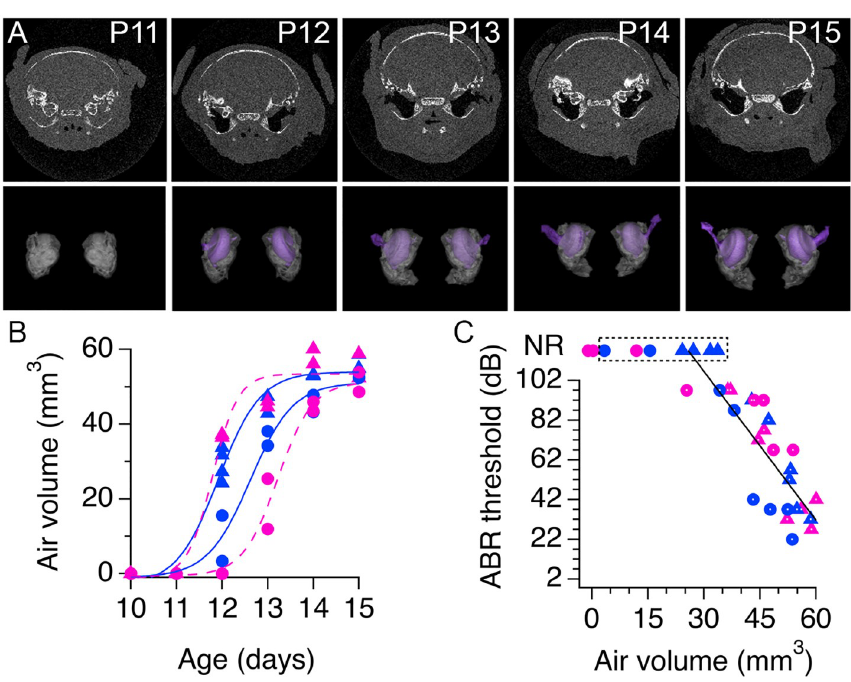
Fig 5. Relationship between development of the middle ear cavity and auditory brainstem response (ABR) wave 1 thresholds. A , Top, developmental series of micro-CT X-ray scans of pups from a low licking and grooming (low-LG) litter. White indicates bone, grey is soft tissue and black is air. Bottom, 3D rendering of segmented bone (gray) and air (purple) contrast obtained from tomographic data. B , Air volume measured at different ages in pups from two low-LG (magenta) and two high licking and grooming (high-LG) litters (blue). Note that every symbol represents one pup and that similar symbols represent pups from the same litter. Continuous and dotted color lines are fits of Eq 1 to the data. C , Relationship between ABR wave 1 thresholds and air volume in the middle ear cavity. Magenta circles and triangles represent pups from low-LG litters (n = 25 pups); blue circles and triangles represent pups from high-LG litters (n = 26 pups). NR = non-responsive pups, defined by the absence of ABR wave 1. Black line represents the fit to a linear function between wave 1 thresholds and air volume with slope 2.5 dB/mm 3 . Symbols with white dots indicate data points included in the